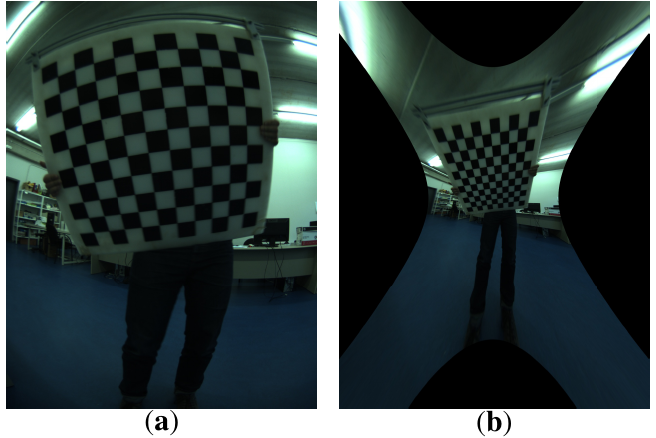
Figure 8. A sample image of a checker board captured by a wide-angle lens camera used for any standard calibration toolboxes, before ( a ) and after ( b ) the distortion correction. (a) Original image; (b) undistorted